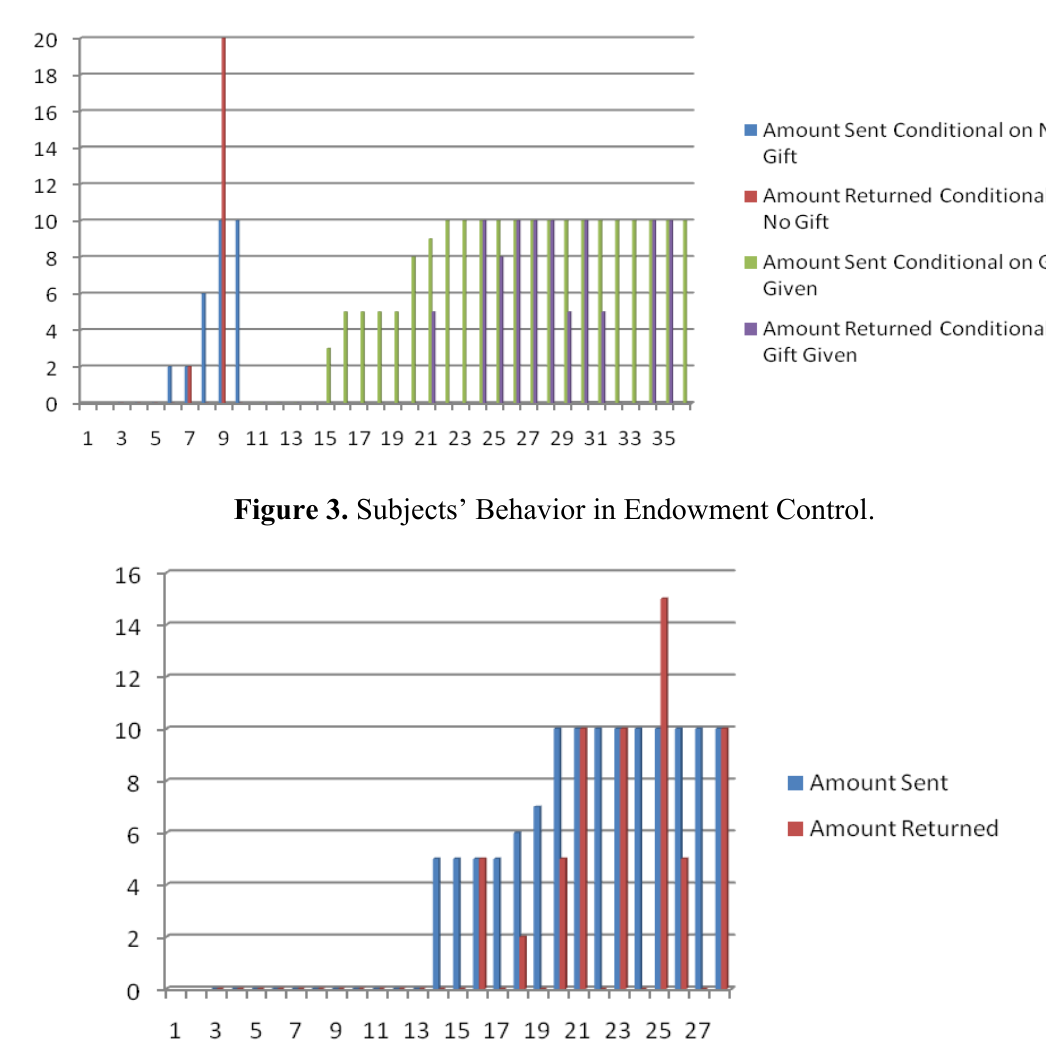
Figure 2. Subjects’ Behavior in Gift.